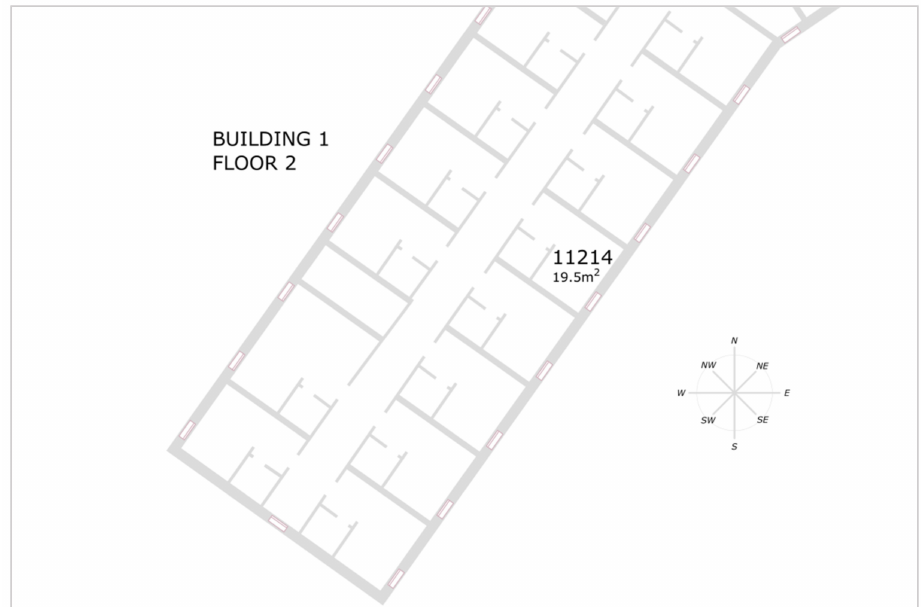
Figure 36. Case study 1: Building 1, apartment 11214.